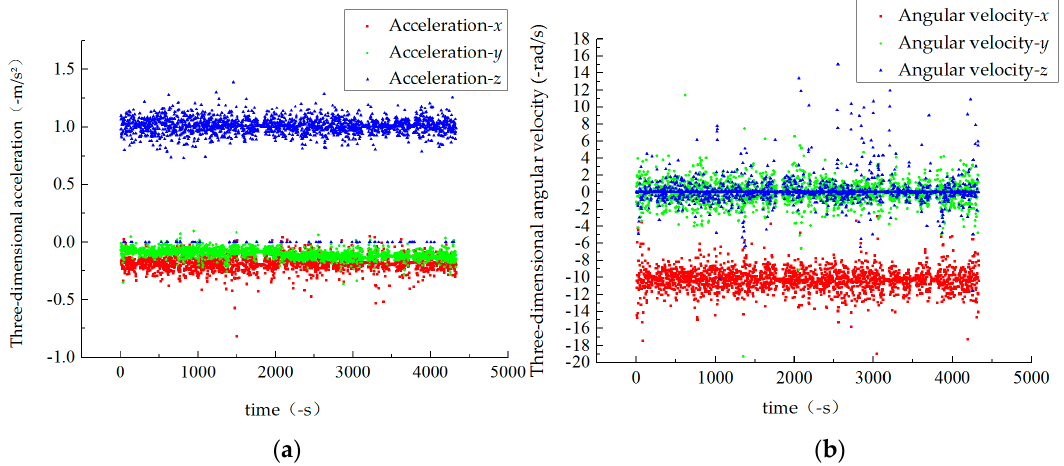
Figure1. Scatter plot of reference data: ( a ) acceleration and ( b ) angular velocity. Figure 1. Scatter plot of reference data: ( a ) acceleration and ( b ) angular